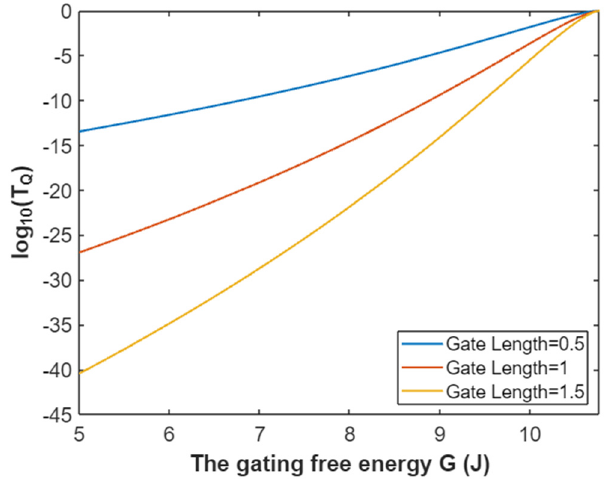
Figure 7. The relationship between gating free energy and the common logarithm of tunneling